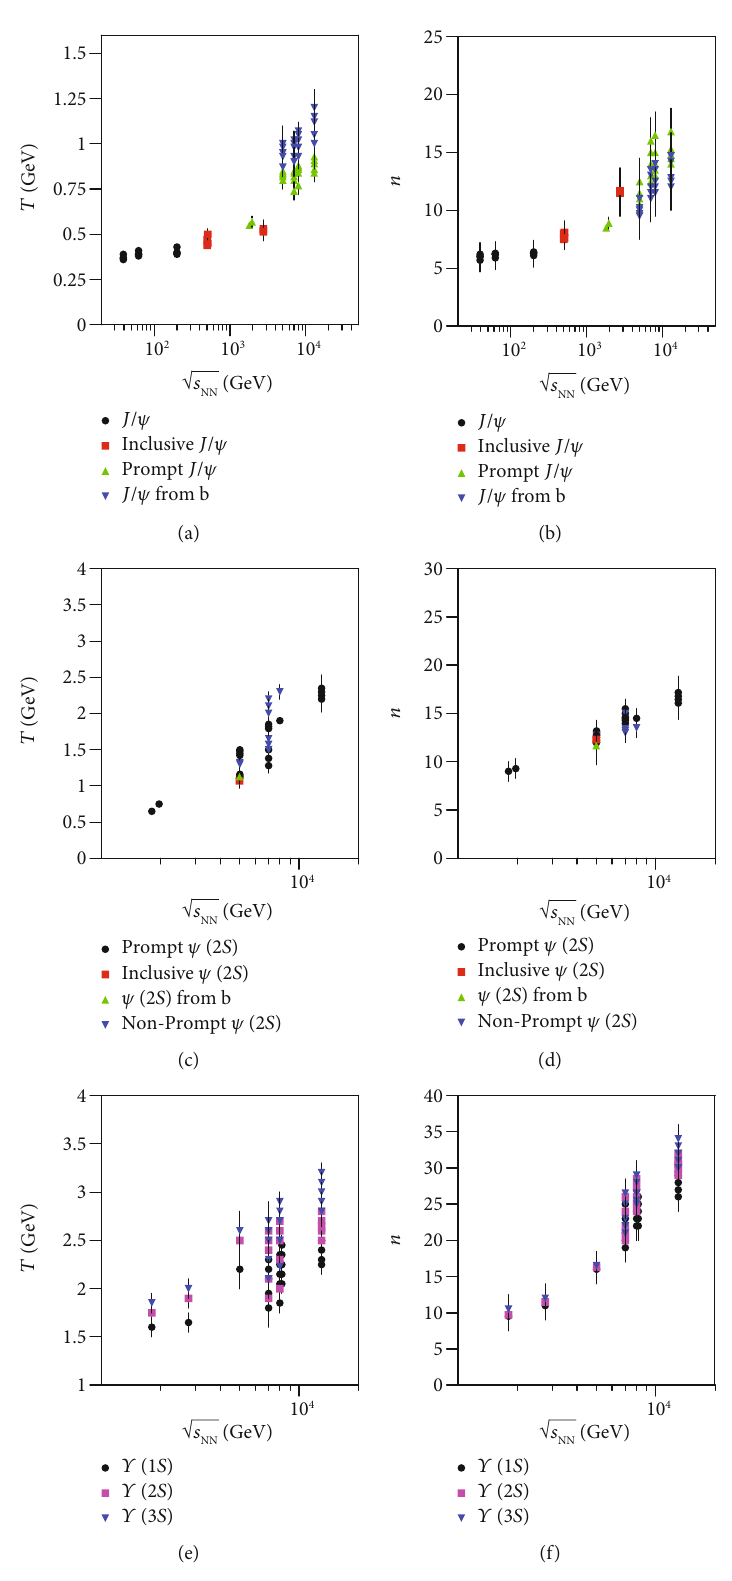
Figure 11: Same as Figure 7, but showing the dependences of (a, c, and e) T and (b, d, f) n on and (e, f) Y ð nS , n = 1, 2, 3 Þ , where T is not the initial temperature, but an e ff ective temperature parameter in the Tsallis-Levy